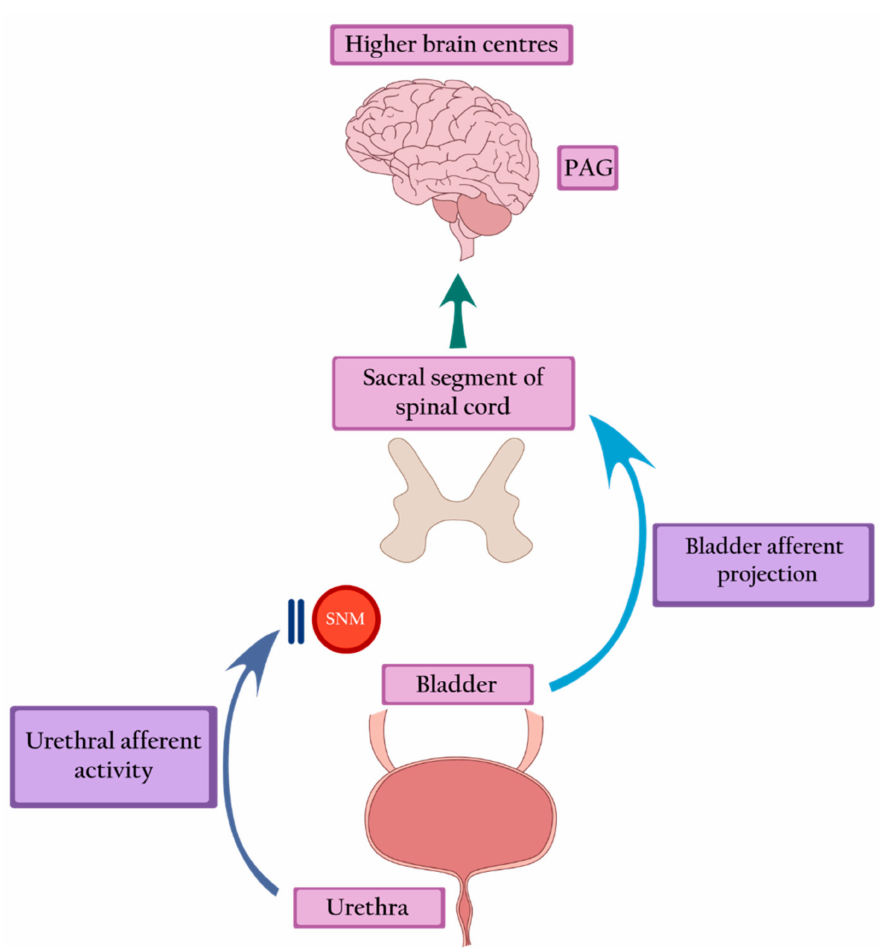
Figure 3. Sacral neuromodulation blocks urethral inhibition and restores bladder afferent projection, leading to the return of bladder sensation and activation of the PAG. PAG—periaqueductal grey, SNM—sacral